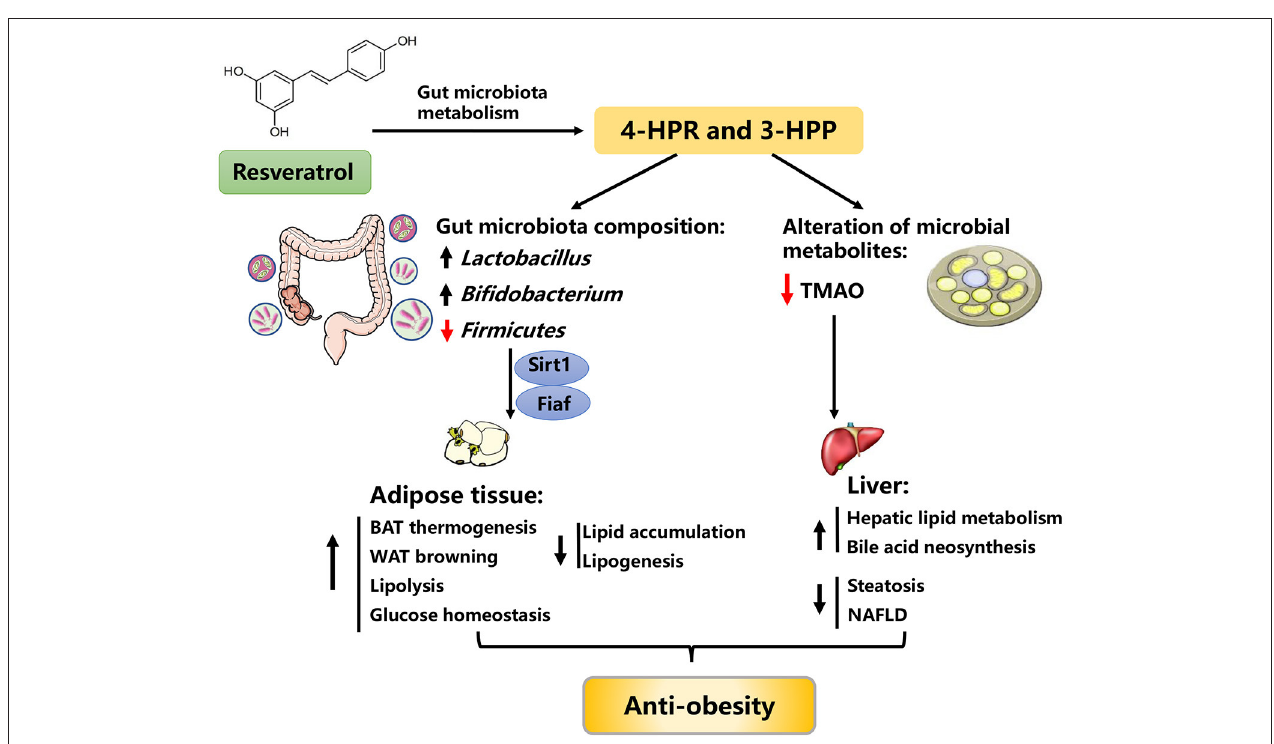
FIGURE 4 | Possible mechanisms explaining the anti-obesity effects of resveratrol. 4-HPA, 4-hydroxyphenylacetic acid; 3-HPP, 3-hydroxyphenylpropionic acid; Fiaf, fasting-induced adipose factor; Sirt1, sirtuin 1; TMAO, trimethylamine-N-oxide, BAT, brown adipose tissue, NAFLD, nonalcoholic fatty liver disease.